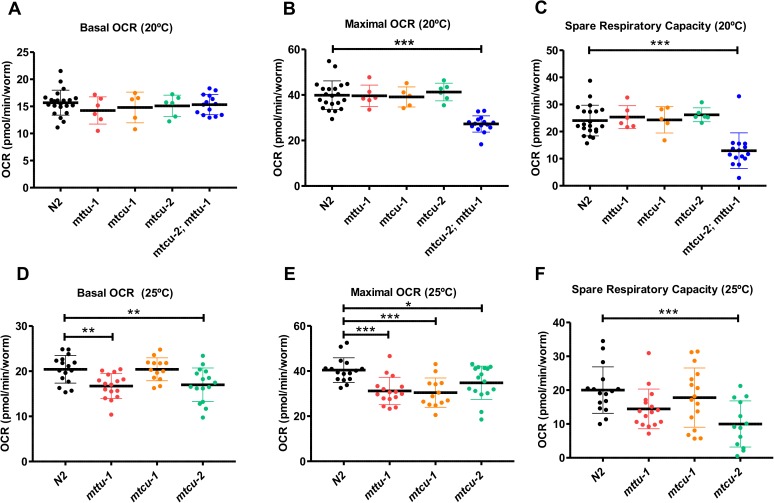
Mitochondrial respiratory capacity of the mttu-1, mtcu-1, mtcu-2 and mtcu-2; mttu-1 mutants.(A-C) Basal (A) and maximal (B) oxygen consumption rates and spare respiratory capacity (C) of worms grown at 20°C. Statistical significance for the double mutant was evaluated with unpaired T-test with Welch’s correction. *** denotes p<0.0001. (D-F) Basal (D) and maximal (E) oxygen consumption rates and spare respiratory capacity (F) of worms grown at 25°C. Statistical significance for the single mutants was evaluated with one-way ANOVA with a Dunnett’s post hoc test for multiple comparisons. *, ** and *** denote p<0.05, p<0.01 and p<0.001, respectively. Data is represented as mean ± SD.